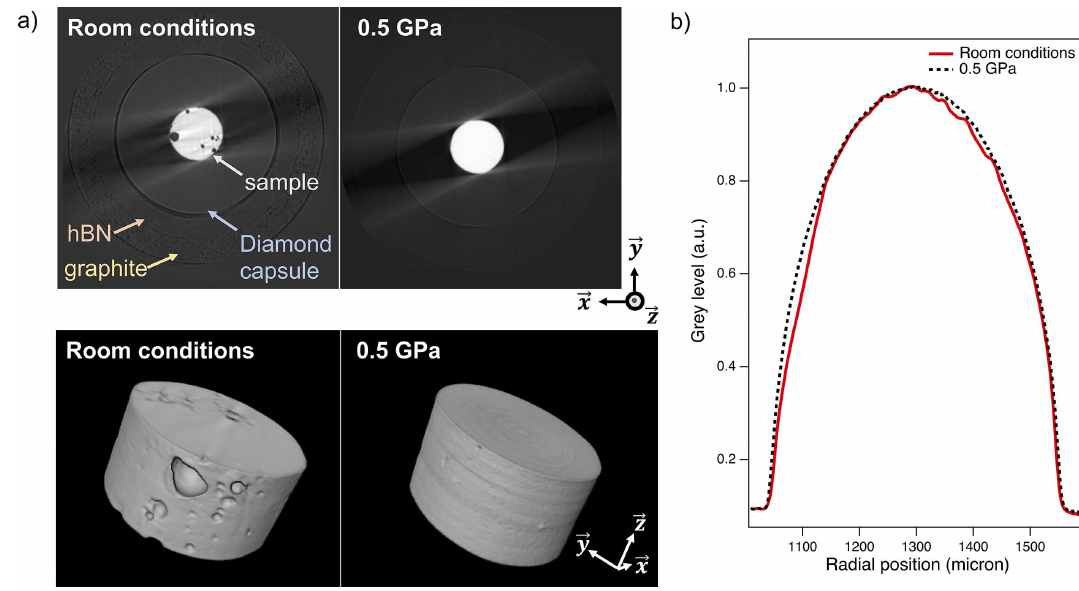
Figure 5 ( a ) Reconstructed volume of the sample and surrounding at room conditions and under pressure at 0.5 GPa (top and bottom images show